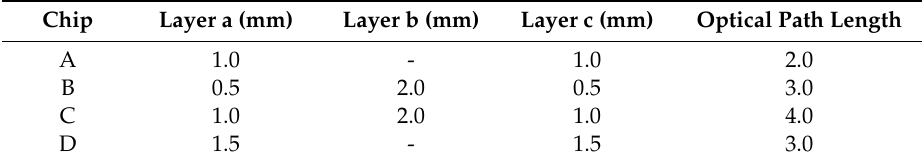
Figure 1. Schematic representation of cyclic olefin copolymer (COC) chips for the color test with an optical path length of 2, 3, or 4 mm for integrated UV-VIS spectroscopy. The insets show chips with an optical path length of 4 mm. The top channel in the top right picture is filled with Allura Red. Table 1. Milling depth in each COC layer and optical path length for various chip designs.